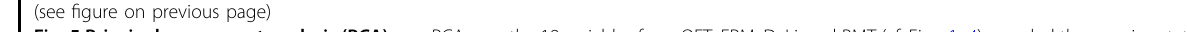
Fig. 5 Principal component analysis (PCA). a – c PCA over the 18 variables from OFT, EPM, DaLi, and BMT (cf. Figs. 1 – 4) revealed three main rotated principal components (PC1r to PC3r). Behavioral readouts with a loading >0.20 or < − 0.20 were highlighted in bold. All variables were weighted according to their loadings and used to calculate individual z -scores for each group and PC. Based on the loadings, the components stand for exploration (PC1r), fear-related behavior (PC2r), and anxiety-related behavior (PC3r), respectively, approach behavior (controlled by the Behavioral Activation System, BAS), avoidance behavior (controlled by the Fight/Flight/Freeze system, FFFS), and con fl ict solving (controlled by the Behavioral Inhibition System, BIS), if translated to the Reinforcement Sensitivity Theory 8,10 . d – f Impact of food restriction on the z -scores for the difference PCs. ### p < 0.001, #### p < 0.0001 respective FR − group. For further details, see Fig. 1. g Spider web plot depicting the individual z -scores for the experimental groups and PCs. The black line corresponds to the grand mean. Data points outside the black circle stand for increased approach, avoidance, and anxiety-related behavior; data points within the black circle for decreased approach, avoidance, and anxiety-related behavior. BMT beetle mania task, CF close following, DaLi dark – light transition task, EPM elevated plus maze, HD head dipping, OAL open arm latency, OFT open fi eld test, PC principal component, SAP stretch-attend posture, TD total distance, TDM total distance moved, TiC time in center, TOA time in open